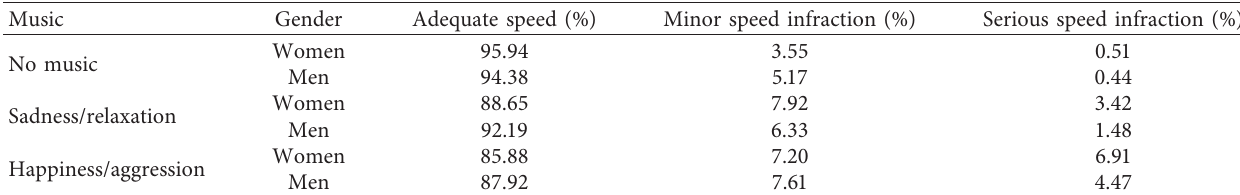
Table 7: Probability of speed infraction depending on music type and